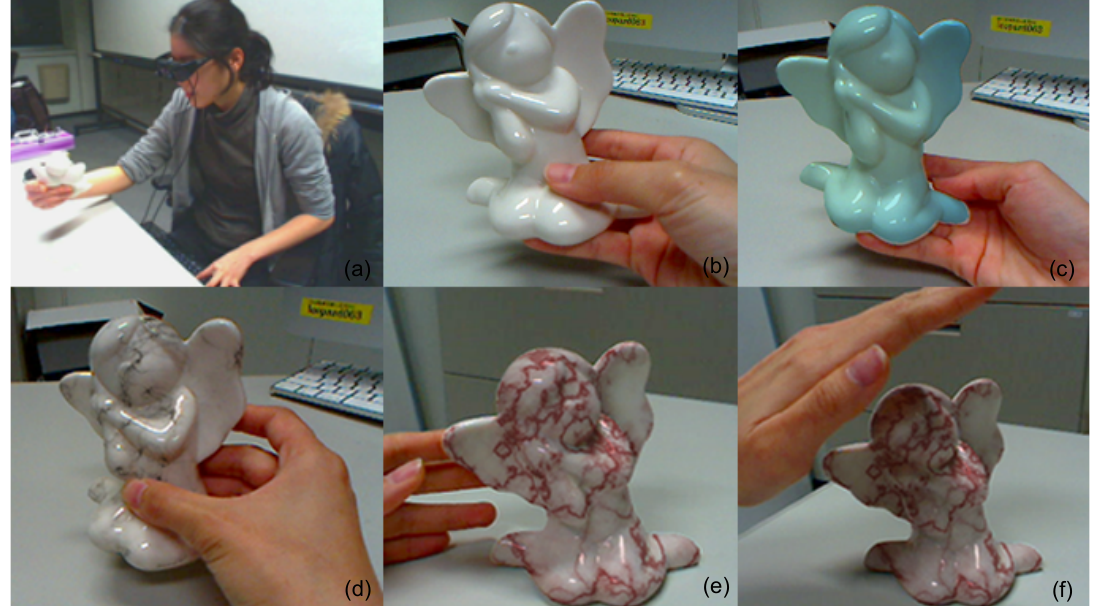
Fig. 18. Image sequence showing the AP application: (a) the ideal scenario, with the user holding the angel figurine and wearing a Head-Mounted Display, from where it is possible to visualize different colors and textures rendered on the object in real-time. In the sequence, (b) the original object, without any texture, followed by (c) an augmented image of the same object with a blue color. Different textures were also tried and the object is shown in different views (d)-(f). In (f), the detail of the shadow of the user’s hand is smoothly blended with the object’s virtual texture and realistically rendered.